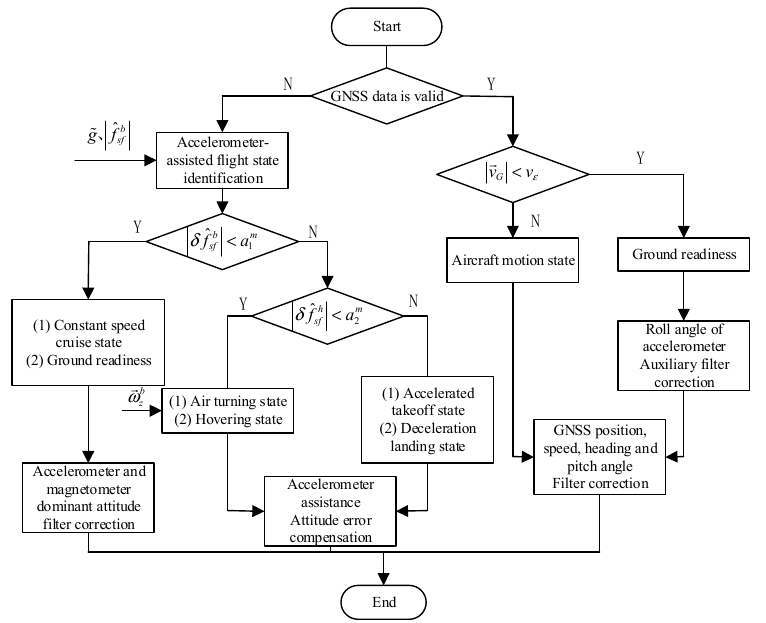
Figure 3. Schematic diagram of flight status identification and navigation correction data selection process.